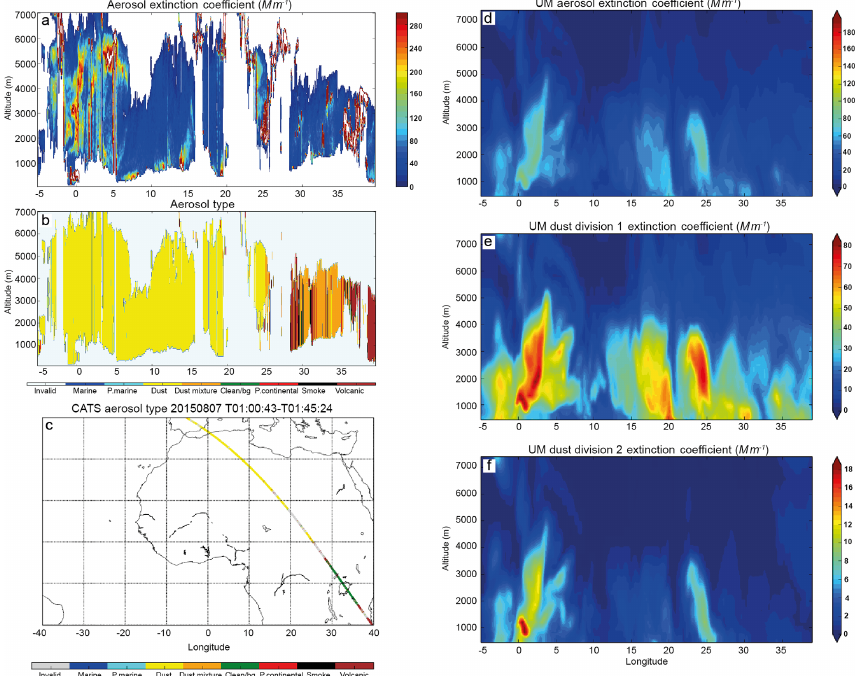
Figure 17. (a–c) CATS and (d–f) MetUM data for 00:00Z on 7 August in the form of vertical cross sections along the satellite track: (a) CATS extinction coefficient; (b) CATS feature type; (c) CATS overpass track; (d) MetUM total dust extinction coefficient; (e) MetUM d1 dust extinction coefficient; and (f) MetUM d2 dust extinction coefficient.